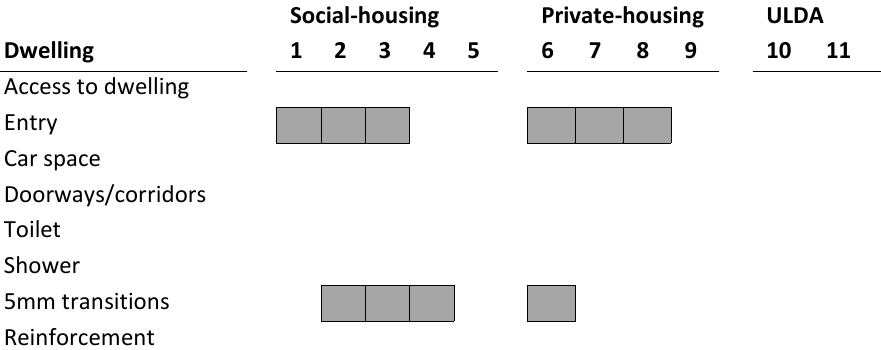
Table 2. Non-compliant features due to “lack of